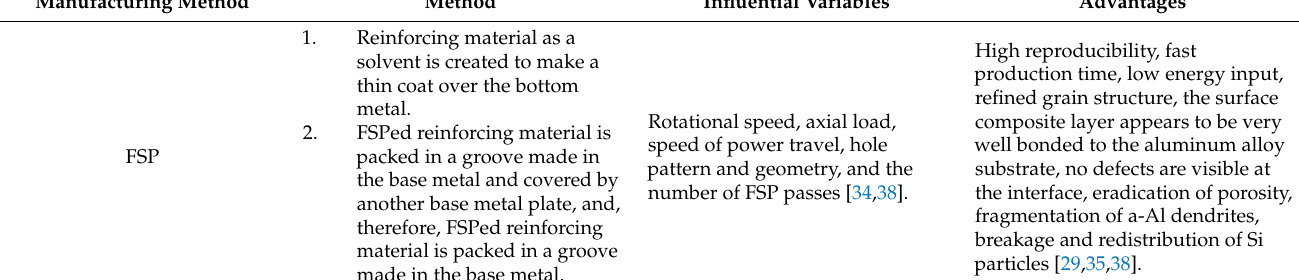
Table 4. The summary of solid-state